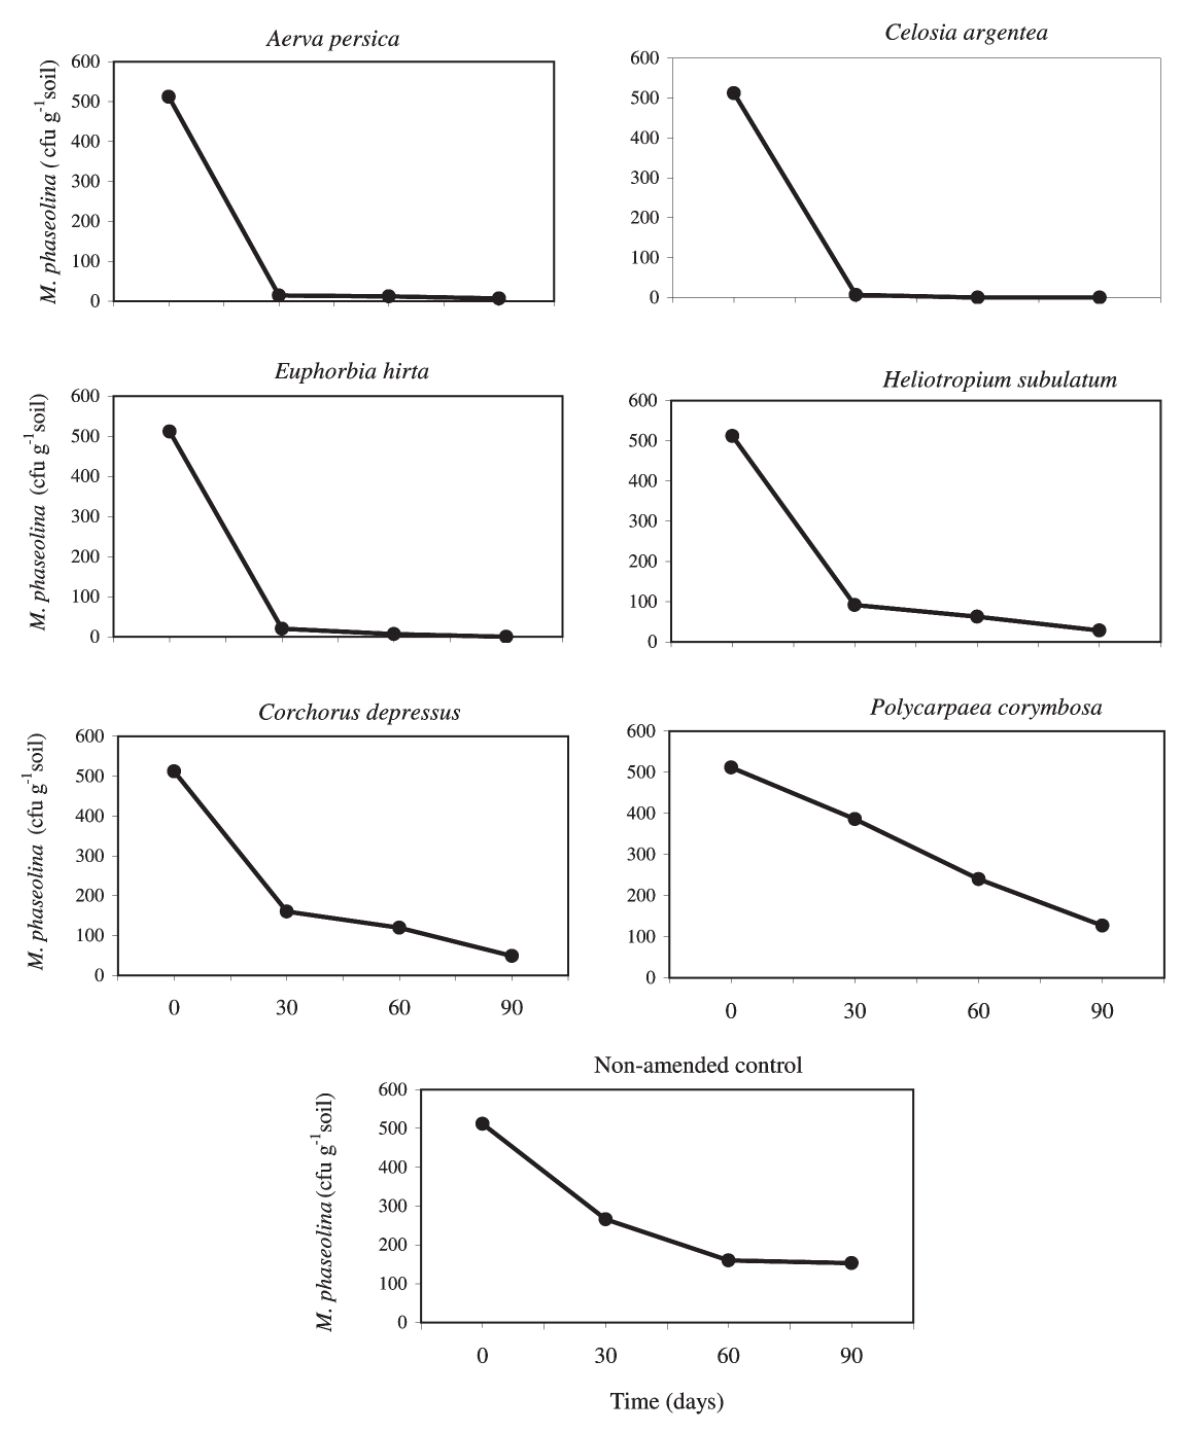
Fig.1. Population changes of Macrophomina phaseolina in weed residue amended and non-amended soils recorded at 30-day intervals (LSD [ P =0.05]): Treatment 9.3; Interval 9.0; Treatment (cid:1) Time in days (of a particular amend- ment) 23.8; and Treatment (cid:1) Time in days [at a fixed interval]